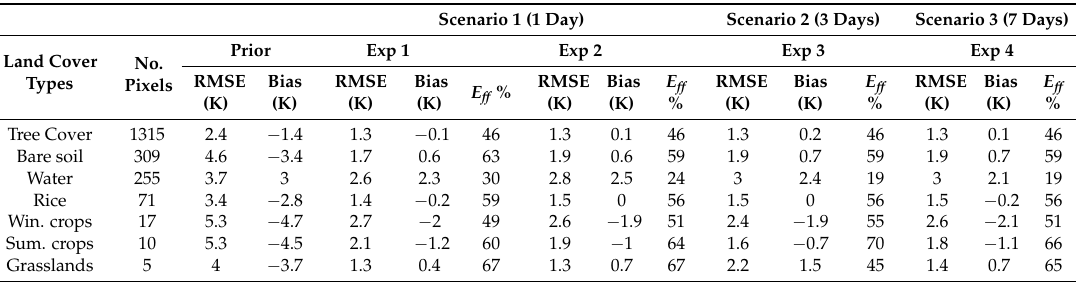
Table 4. GPS downscaling results by class averaged over MODIS homogeneous pixels and the 23 considered validation dates, compared to SETHYS prior